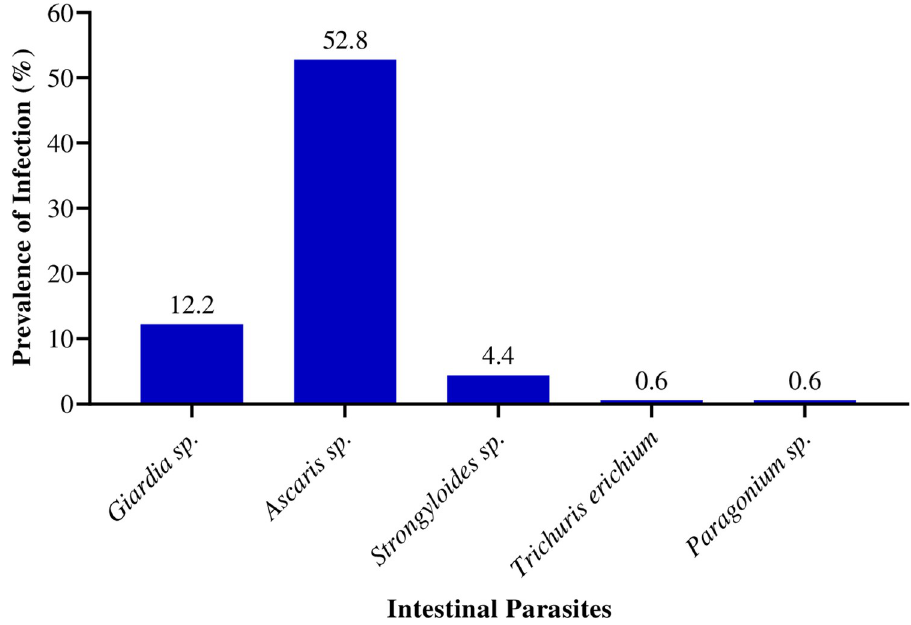
Fig 3. Prevalence of other intestinal parasites.